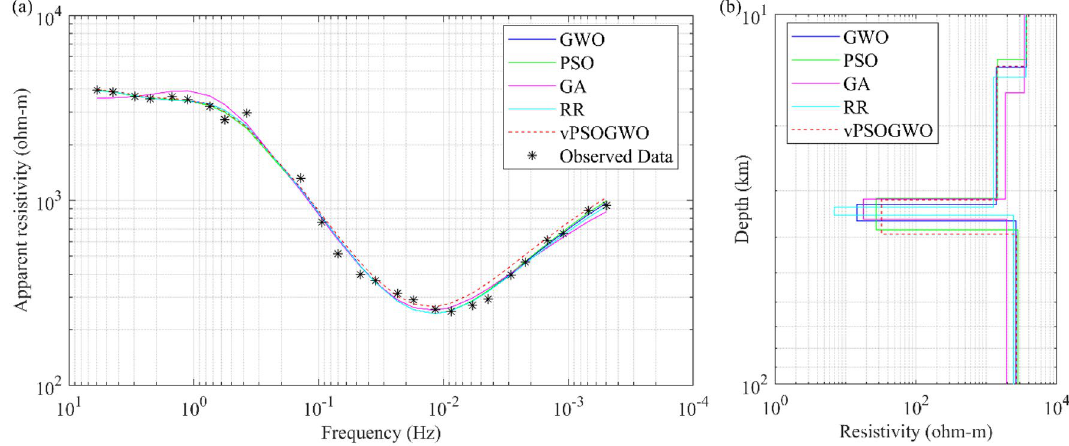
Figure 15. Four-layers MT field data over Sundar Pahari, Dhanbad, India: ( a ) observed (*) and the best-fitted apparent resistivity curve using GWO, PSO, GA, RR, and vPSOGWO; ( b ) 1-D mean model (bpdf > 68.27% CI) inverted by vPSOGWO (red), RR (cyan), GA (magenta), PSO (Green) and GWO